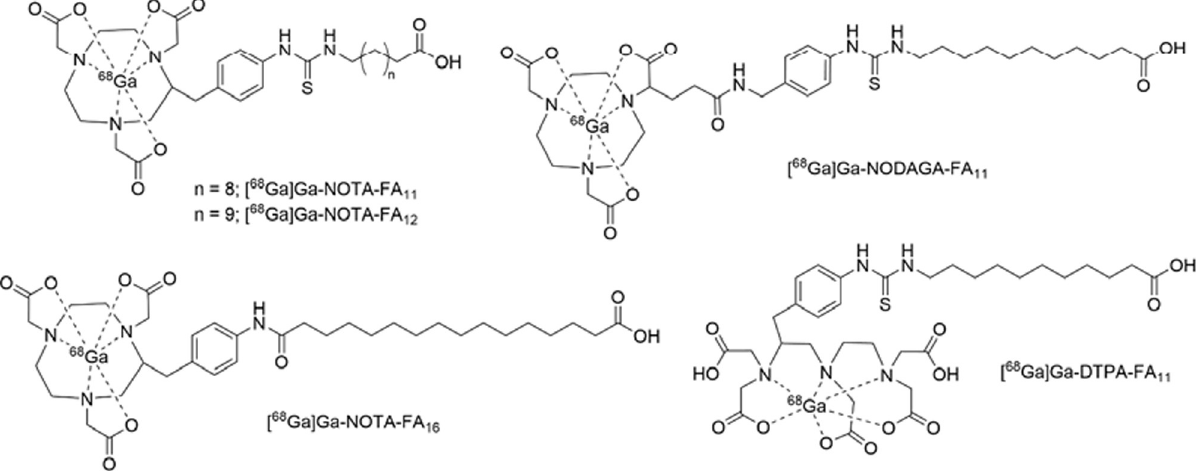
Fig 4. Chemical structures of [ 67 Ga]Ga-NOTA-FA 11 , [ 67 Ga]Ga-NOTA-FA 12 , [ 67 Ga]Ga-NODAGA-FA 11 , [ 67 Ga]Ga-NOTA-FA 16 , and [ 67 Ga]Ga- DTPA-FA 11